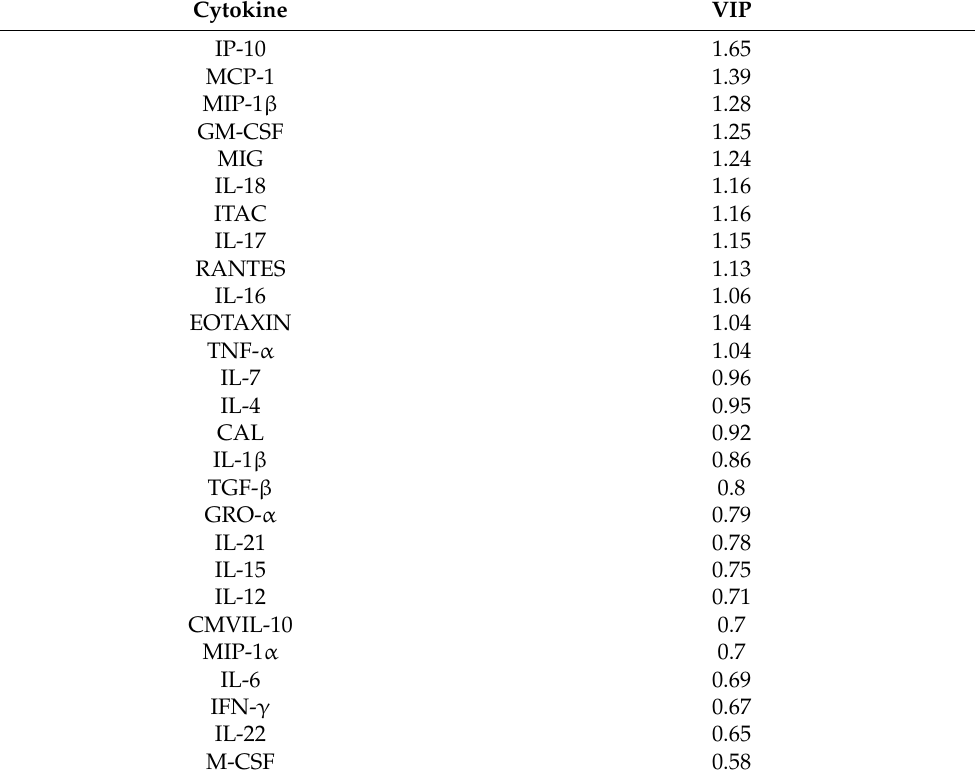
Table 3. VIP scores for each cytokine: people with and without HIV. Cytokine VIP IP-10 1.65